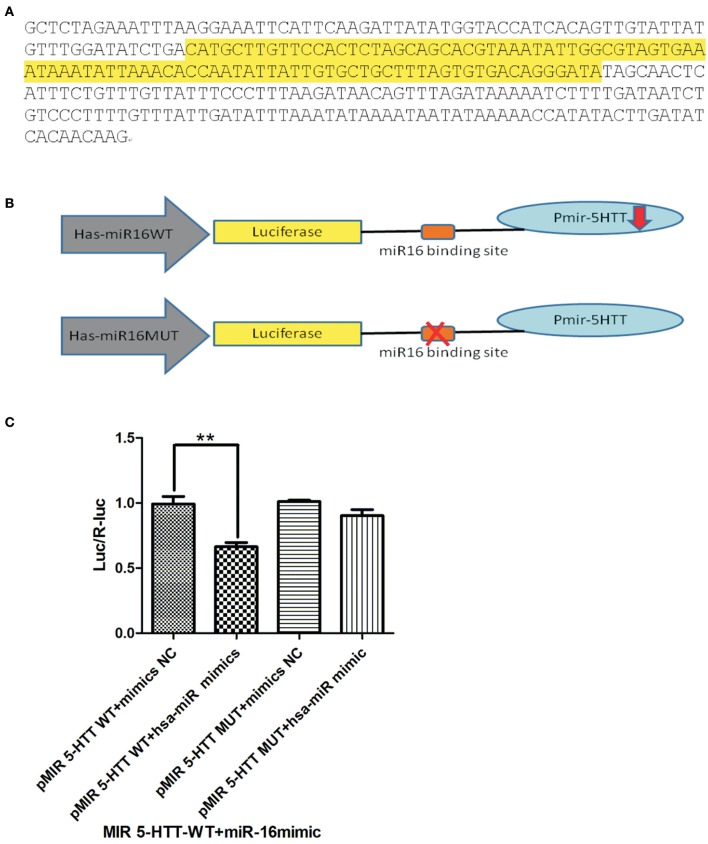
Hsa-miR-16 can regulate Luciferase expression by binding to the 3′UTR region of 5-HTT. The dual-luciferase reporter assay system verifies that hsa-miR-16 targets 3′UTR of gene 5-HTT and exerts an inhibitory effect. (A) Genome sequence of miR-16 is shown in the figure, and the highlighted part is stem-loop region. (B) Simple diagram of the luciferase experiment. The WT miR-16 and MUT miR-16 were co-transfected with 5-HTT. In order to reaffirm 3′UTR as the active site between hsa-miR-16 and its target gene 5-HTT, the expression of luciferase, which contained 3′UTR of 5-HTT, was measured under hsa-miR-16 over-expression. (C) The histogram shows that hsa-miR-16 can regulate Luciferase expression (**P < 0.01) via the 3′UTR region of 5-HTT, while a mutation of the binding site stops this effect, thus confirming that hsa-miR-16 regulates Luciferase expression through this binding sites.